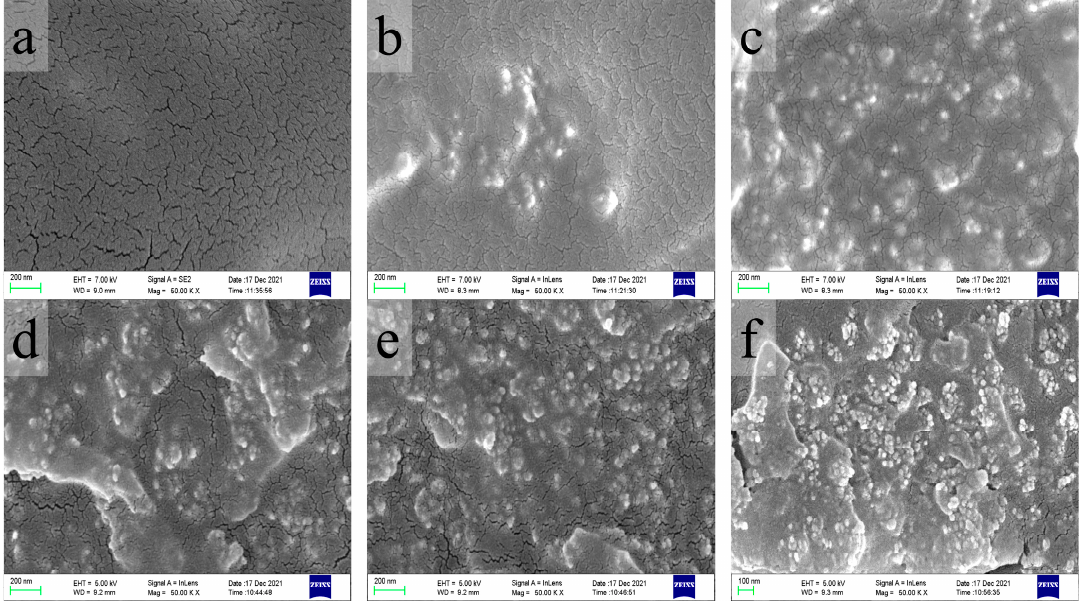
Figure 6. SEM images of the fractured sections after tensile tests for the composites with ( a ) 0; ( b ) 2 wt.%; ( c ) 4 wt.%; ( d ) 6 wt.%; ( e ) 8 wt.%; and ( f ) 10 wt.%.